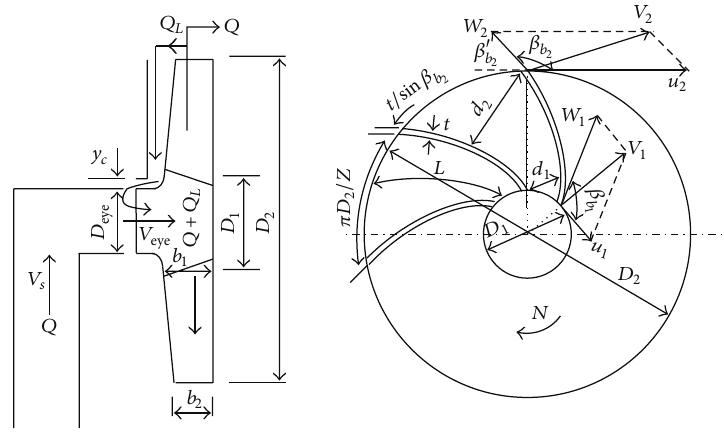
Figure 1: Pump impeller notations.